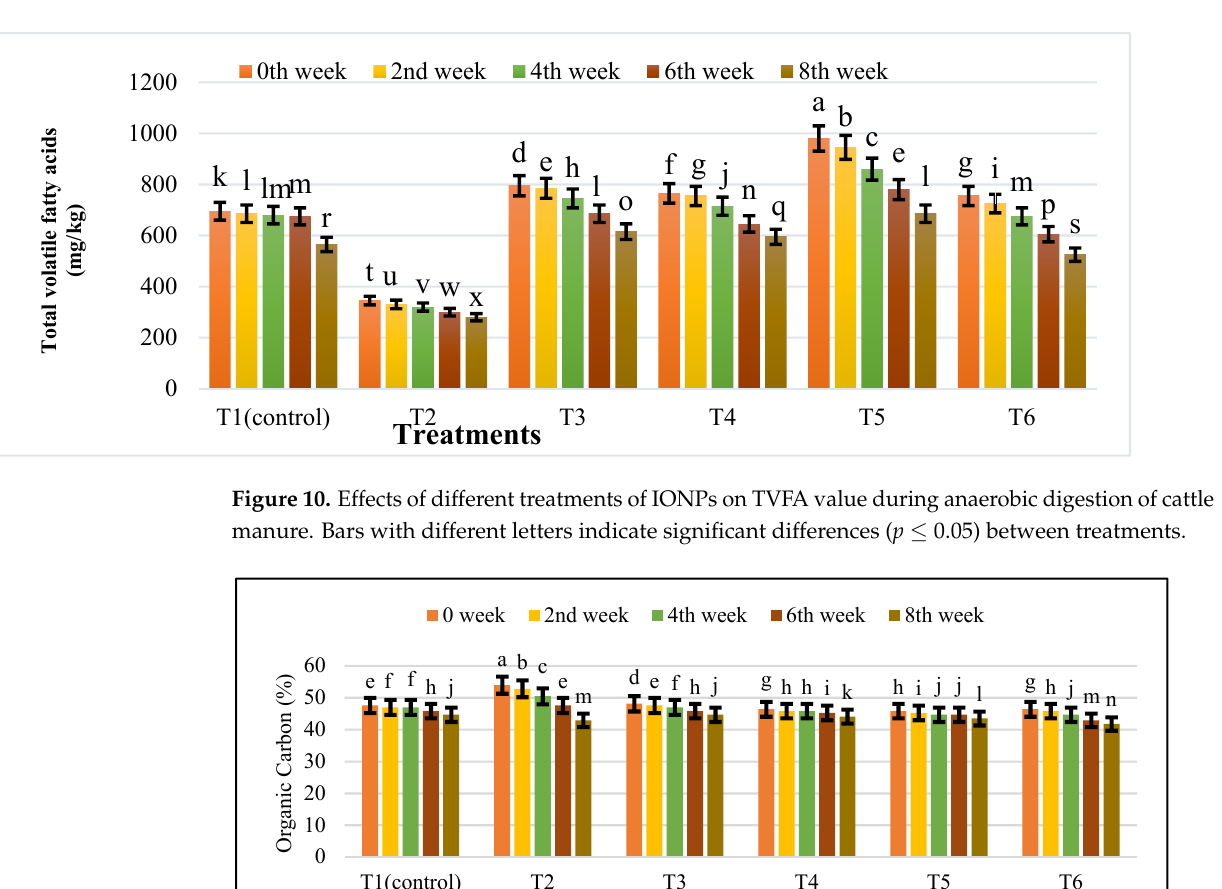
Figure 10. Effects of different treatments of IONPs on TVFA value during anaerobic digestion of cattle manure. Bars with different letters indicate significant differences ( p ≤ 0.05) between treatments.